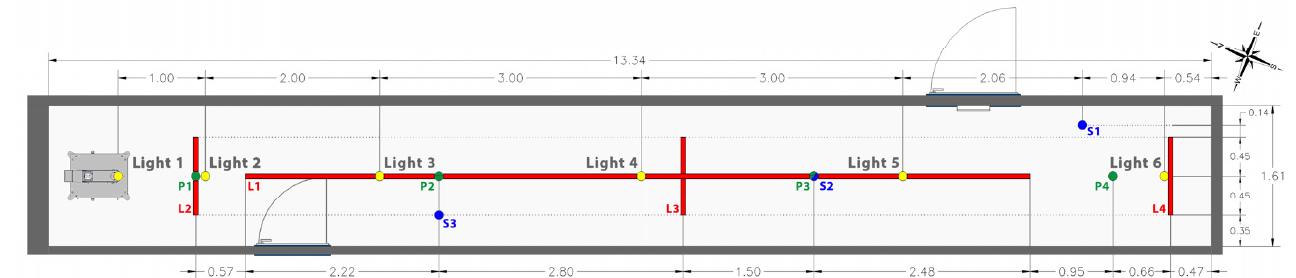
Figure A2. Room 2 (R2) floor plan with test points (P1–P5) and test lines (L1–L4) for the performance of physical activities and spectrum test points (S1–S5).